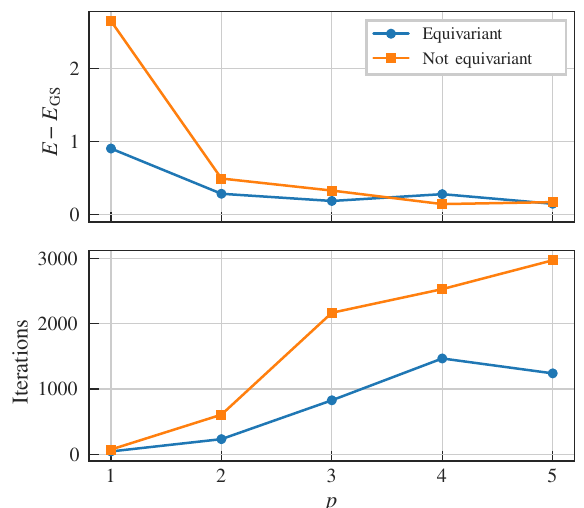
FIG. 13. Comparison of the equivariant and the nonequivari- ant ansätze for the TTT-LTFIM model. For every number of layers p , we perform ten experiments with random initializa- tions of the parameters and plot the difference between the mean achieved energy and the ground state energy (top) and the num- ber of iterations necessary to reach it (bottom). For small circuit depths, the equivariant ansatz performs better than the nonequiv- ariant one. This advantage does not seem to persist to higher